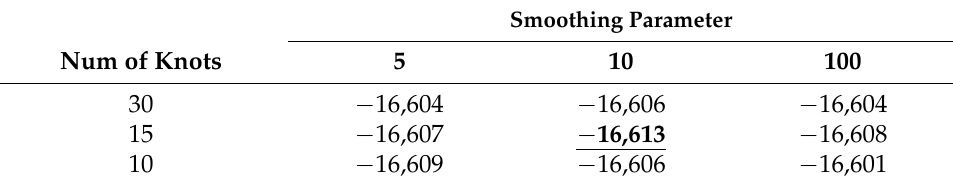
The best of each distribution is underlined, and the best overall is in bold. Table 14. DIC for Gamma distribution (23 June 2016, AGH, Tokyo, Japan). Smoothing Parameter